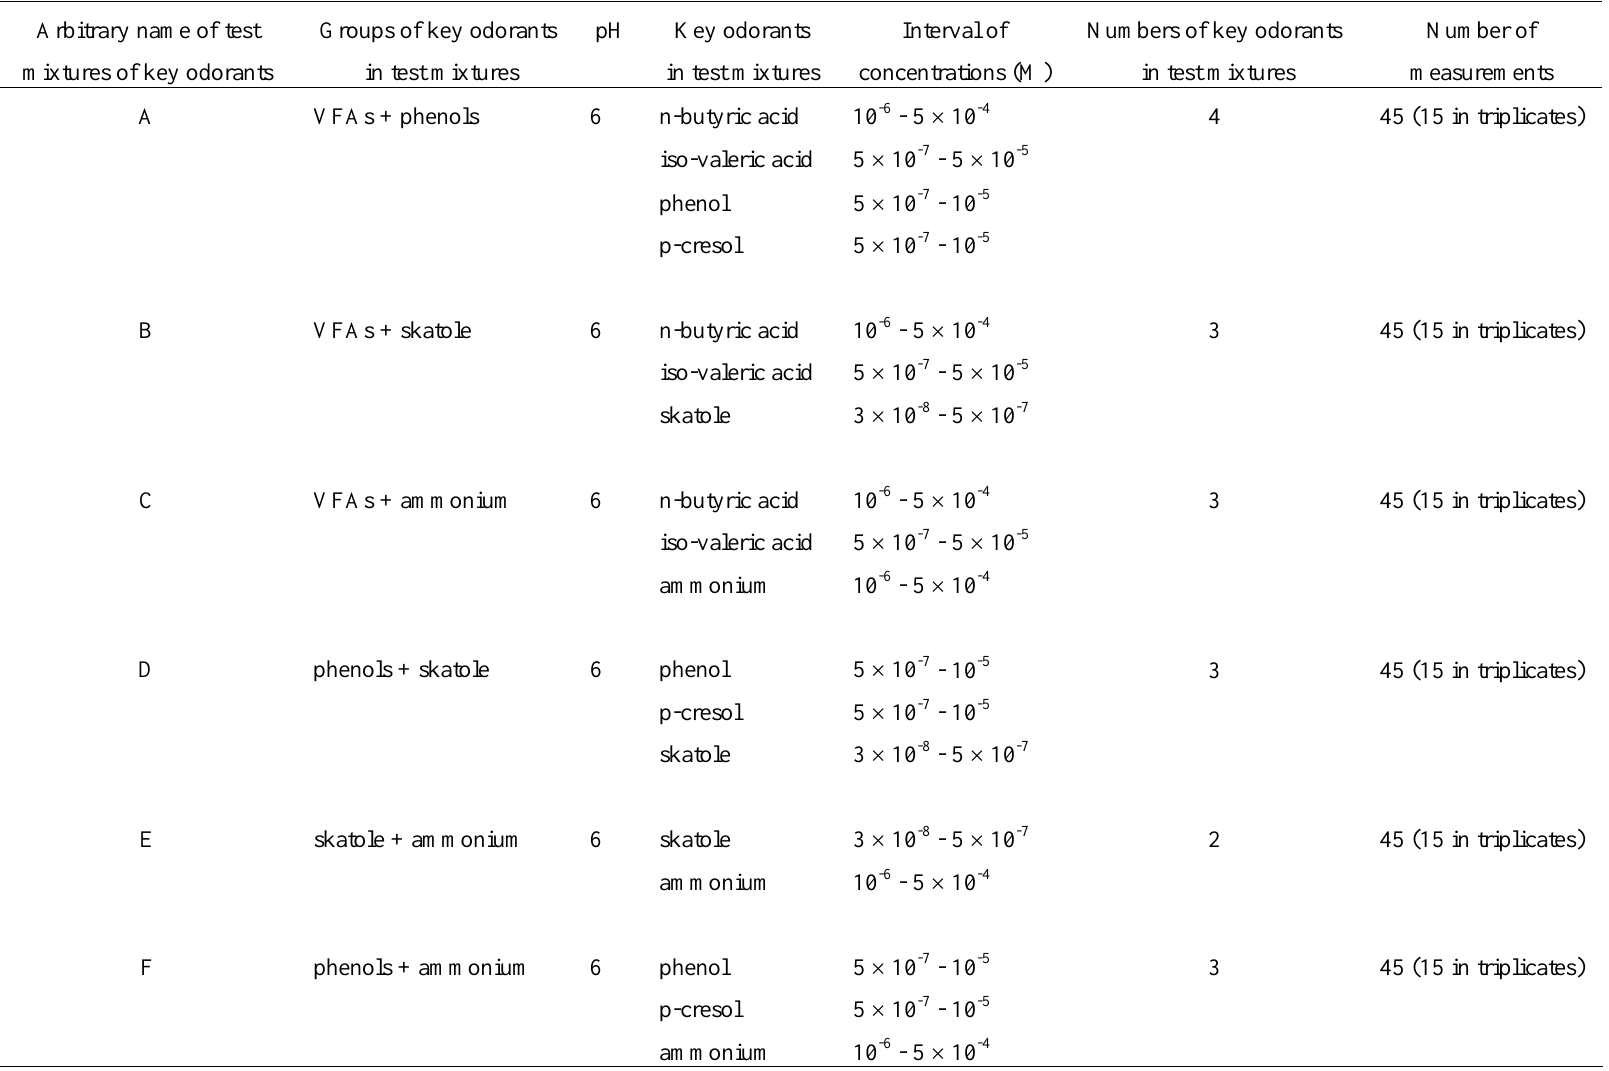
Table 2. Test mixtures of key odorants comprising a variety of chemical groups of selected key odorants at pH